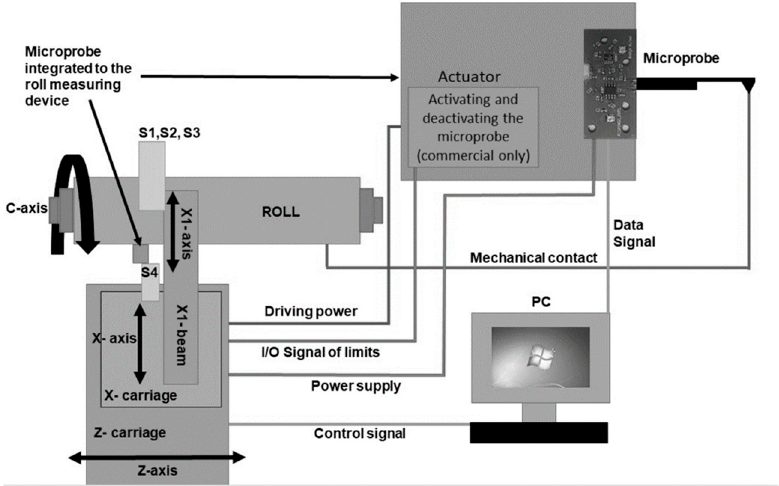
Figure 6. Schematic representation of microprobe integration into a roll measuring device. The mi- croprobe is mounted on a measuring probe (S4) and is in mechanical contact with the roll. Power is supplied from the grinding machine, and the data are processed with and stored on a PC.